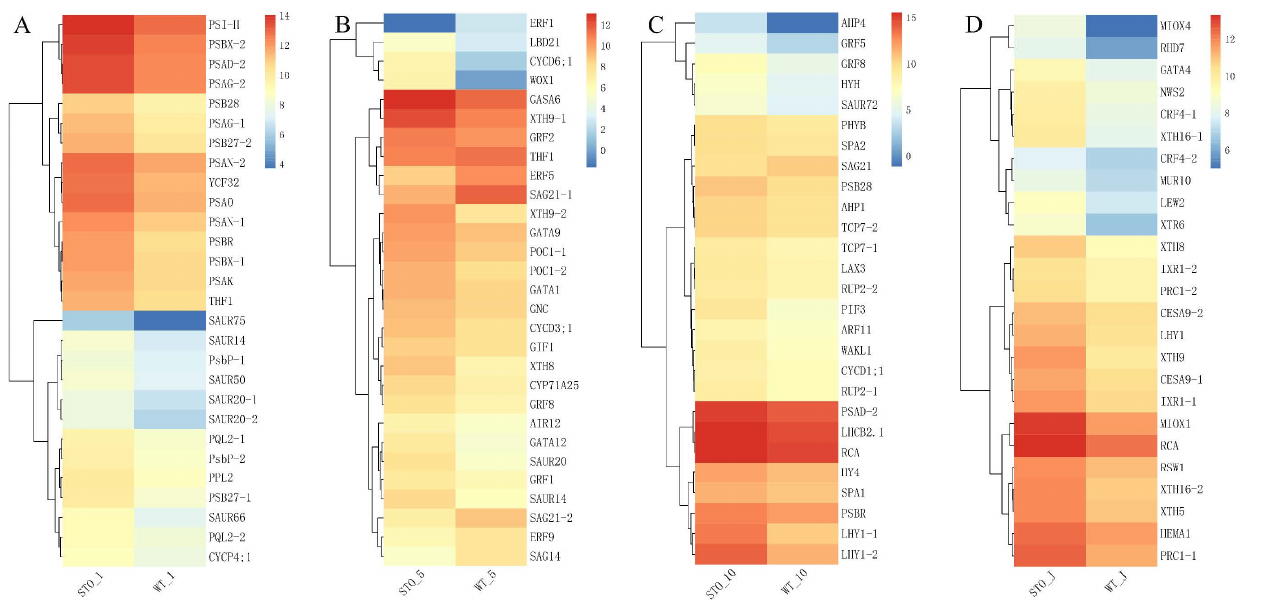
Figure 9. The analysis of changes in DEGs involved in photosynthesis and growth. ( A ) Heatmap of DEGs of STO-OE and WT lines in 1st leaf position. ( B ) Heatmap of DEGs of STO-OE and WT lines in 5th leaf position. ( C ) Heatmap of DEGs of STO-OE and WT lines in 10th leaf position. ( D ) Heatmap of DEGs of STO-OE and WT lines in young stem. The color scale represents the FPKM value.